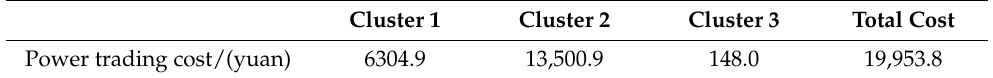
Table 2. Electricity trading cost.